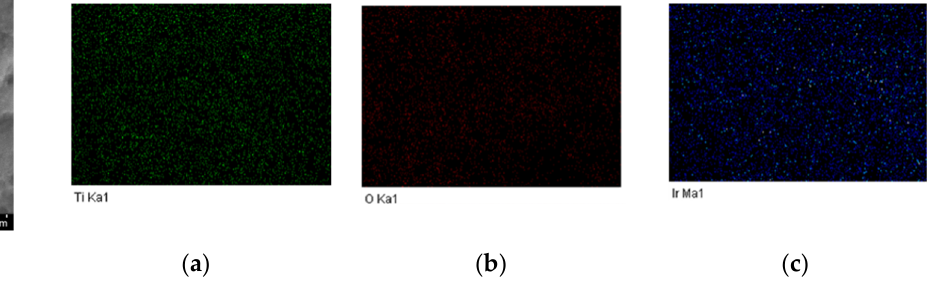
Figure 5. SEM-EDX elemental mapping of ( a ) Ti, ( b ) O, ( c ) Ir for as-synthesized 1.0 mol% Ir-doped TiO (cid:2870) photocatalyst.